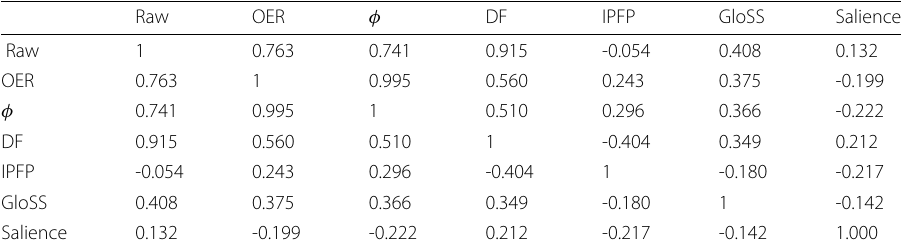
Table 11 The correlation matrix for the hubness score of nodes between different networks, according to the HITS